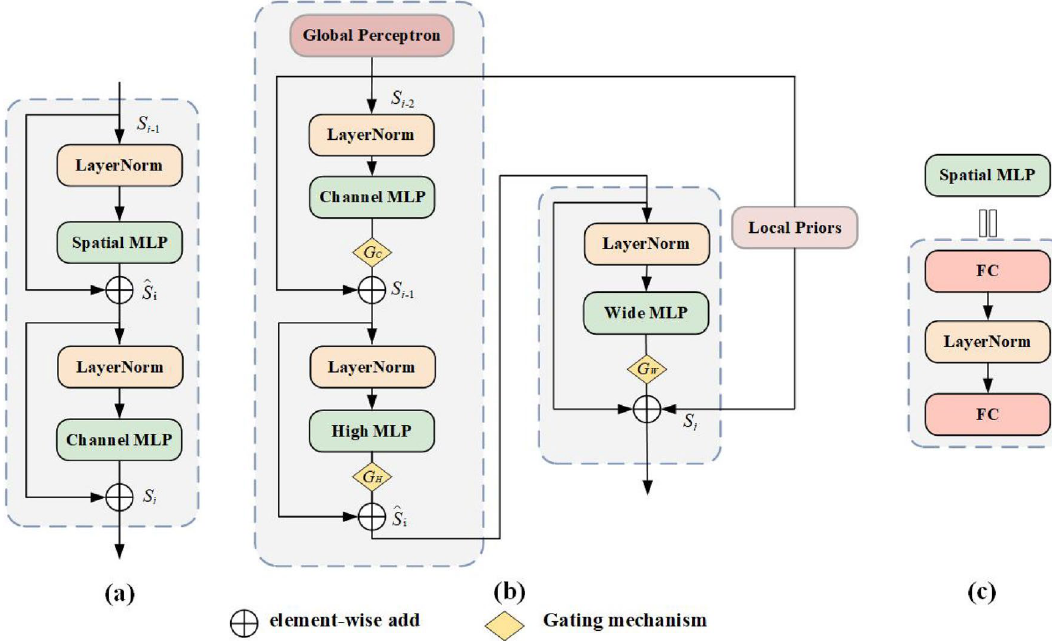
Figure 1. ( a ) is the MLP-Mixer architecture (formulas 1 and 2). ( b ) is the TGMLP architecture (formulas 3, 4 and 5). ( c ) is the spatial MLP architecture wherein Spatial MLP contains two fully connected Layers. (High MLP , Channel MLP and Wide MLP contain only one full connection,